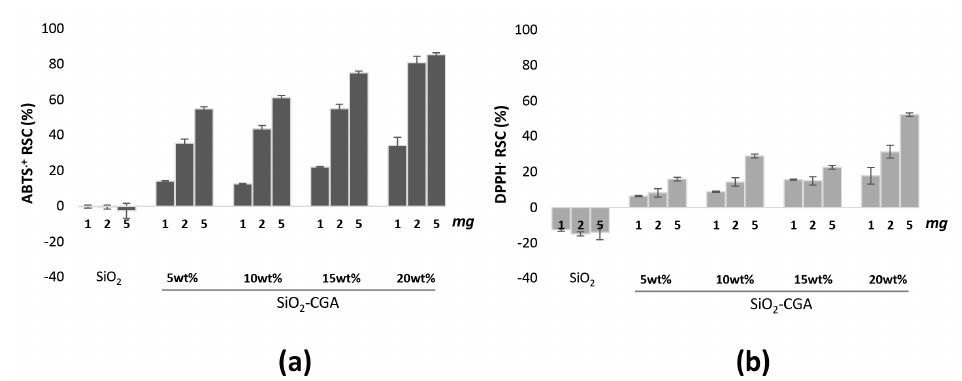
Figure 6. Radical Scavenging Capacity (RSC, %) of different amounts of SiO 2- CGA hybrids, and SiO 2 samples towards ( a ) ABTS •+ and ( b ) DPPH • . Values, reported as percentage vs. a blank, are the mean ± SD of measurements carried out on three samples ( n = 3) analyzed three times.